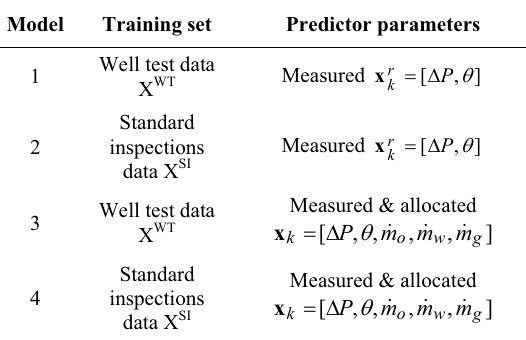
Table 7. Model training